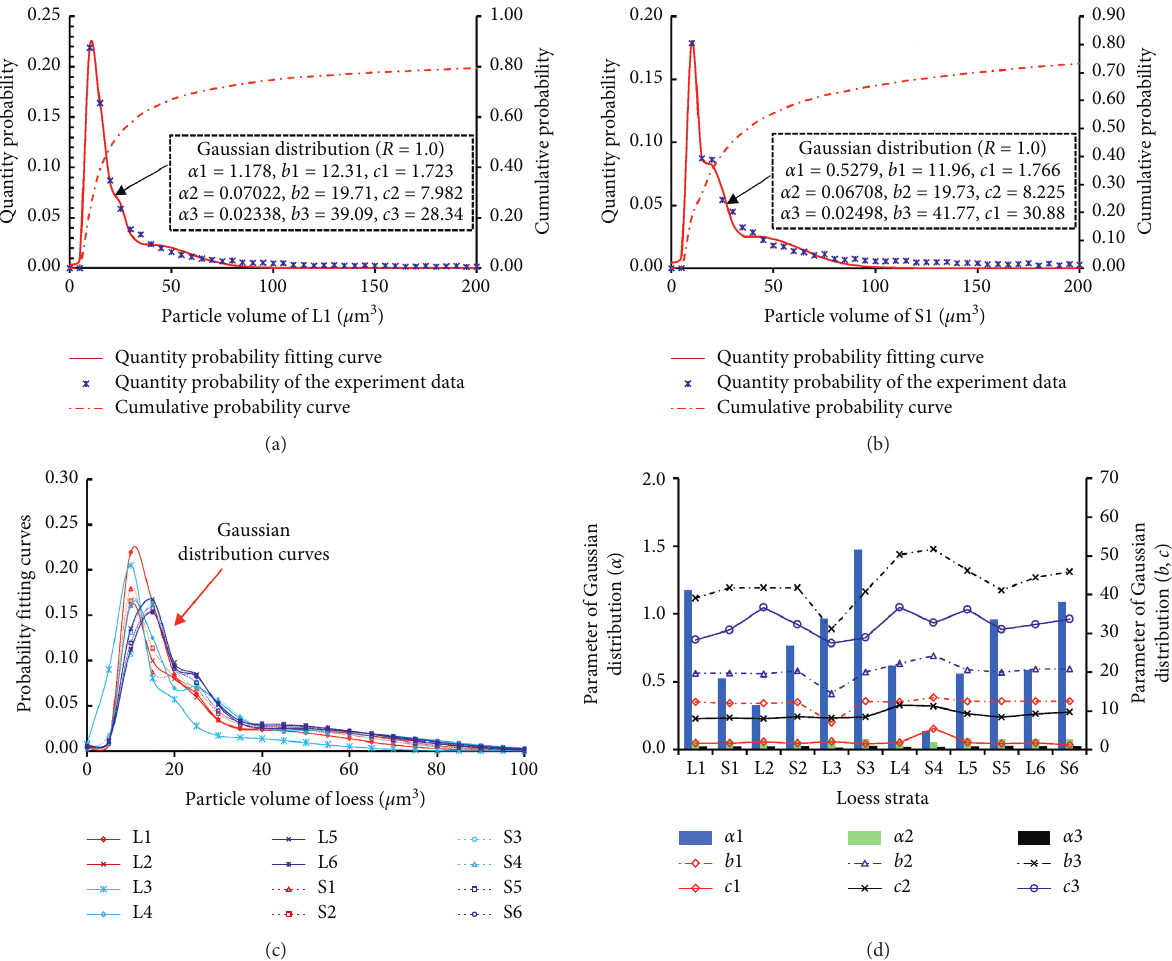
Figure 4: Distribution characteristics of particle volume: (a) L1; (b) S1; (c) comparison of fitting curves for various layers; (d) variation in fitting